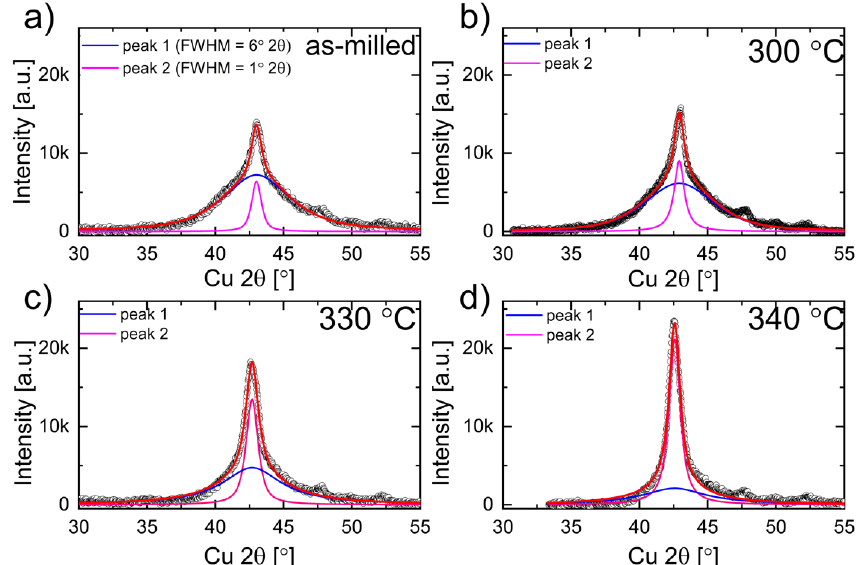
Figure 10. Fitted curves to experimental XRD patterns (black circles) of 100MA powders: ( a ) as-milled (RT), and annealed at: ( b ) 300 °C, ( c ) 330 °C, and ( d ) 340 °C. The fitted summary peak line profile (red line) composed of peak 1 (blue curve) which corresponds to the amorphous fraction and peak 2 (pink curve) to the crystalline fraction observed in 100MA powders.